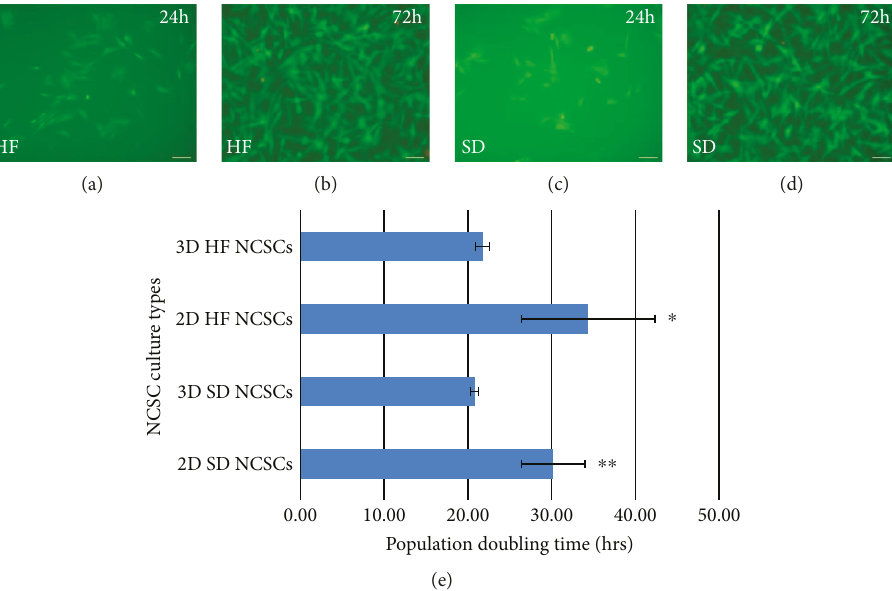
Figure 3: Three-dimensional growth of HF NCSC (a, b) and SD NCSC (c, d) in fi brin hydrogel. Fluorescein diacetate (FDA)/propidium iodide (PI) combined staining for live cells 24 h (a, c) and 72h (b, d) after plating. (e) Diagram of the population doubling time (PDT) values for HF NCSCs and SD NCSCs populations grown in 2D vs. 3D cultures; initial plating: 10 4 cells per 35 mm Petri dish; culture period: 168 h; mean ± SD for cultures from fi ve donors. ∗ p < 0 05 between 2D and 3D HF; ∗∗ p < 0 01 between 2D and 3D